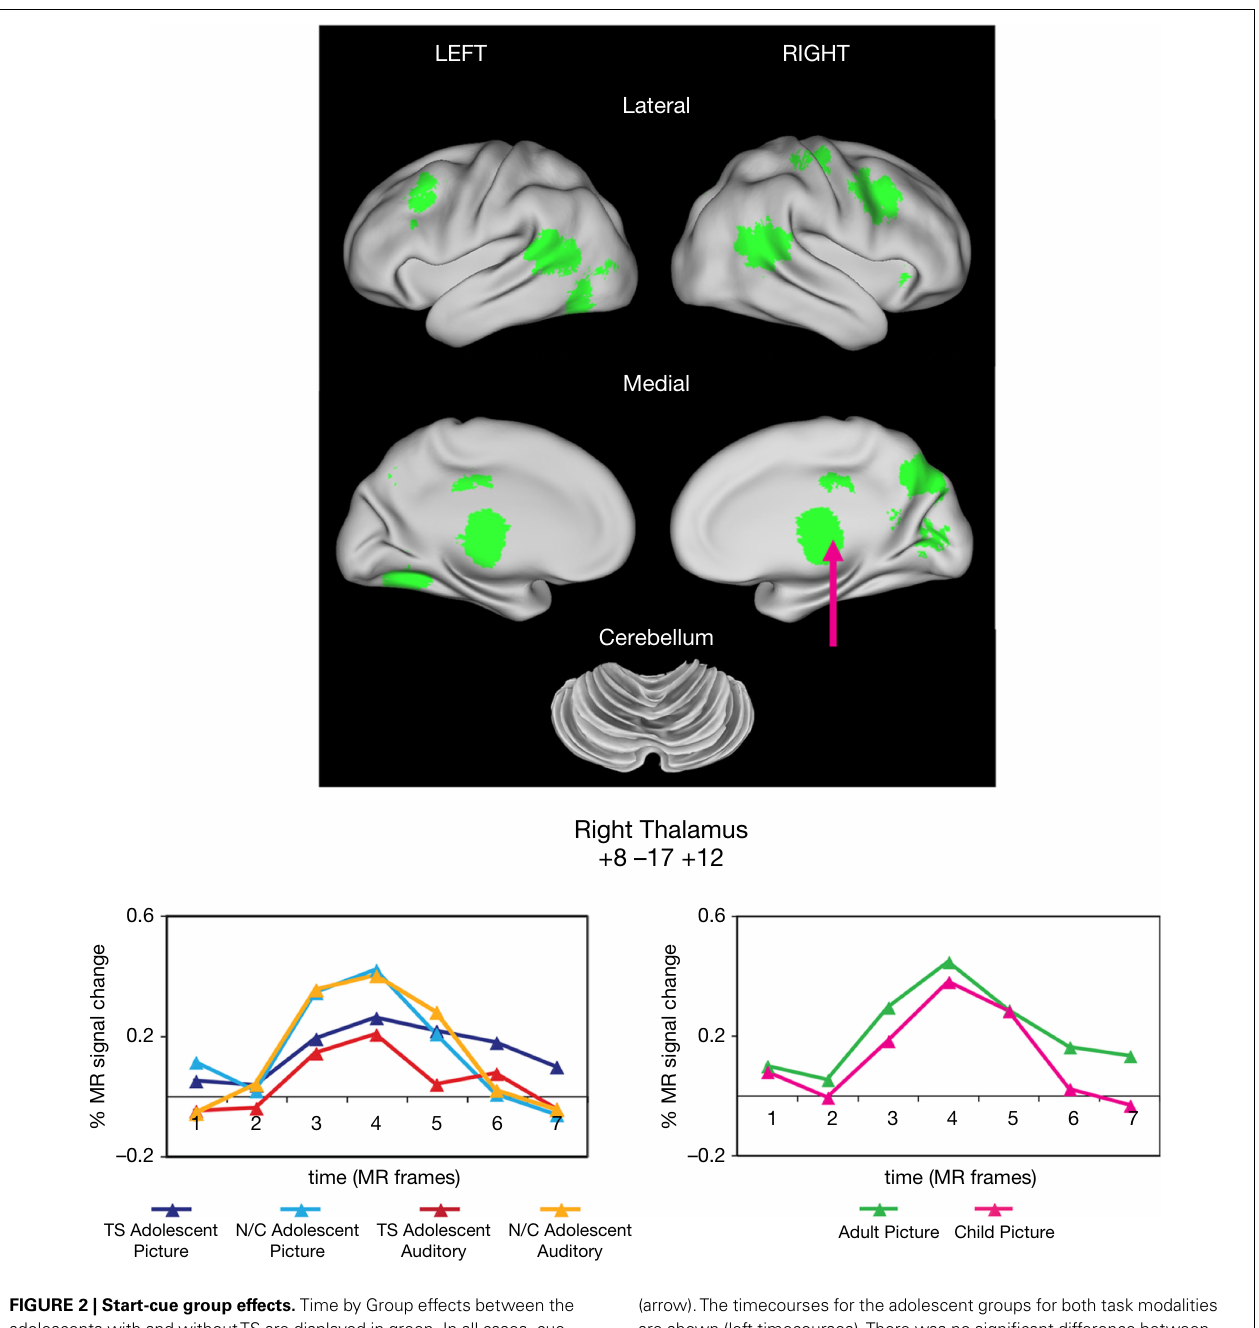
FIGURE 2 | Start-cue group effects. Time by Group effects between the adolescents with and without TS are displayed in green. In all cases, cue activity was greater for the unaffected adolescents (N/C) than those in the TS group. Example timecourses are shown for a region in medial thalamus